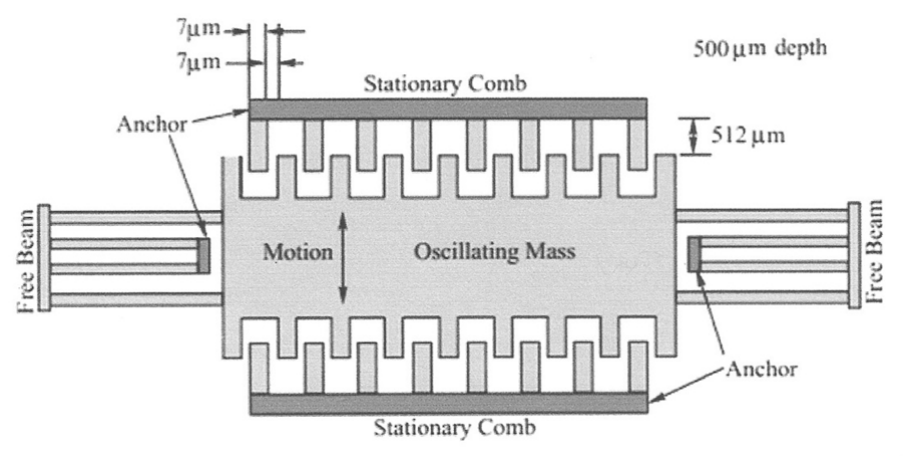
Figure 5. MEMS-based electrostatic transducer (after [MEN